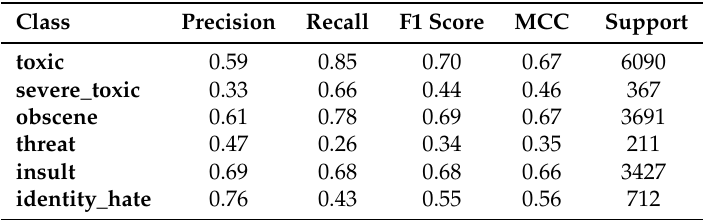
Table 17. Results of the individual toxicity classes of optimized biLSTM + CNN model with pre-trained GloVe Twitter embeddings without standard pre-processing.